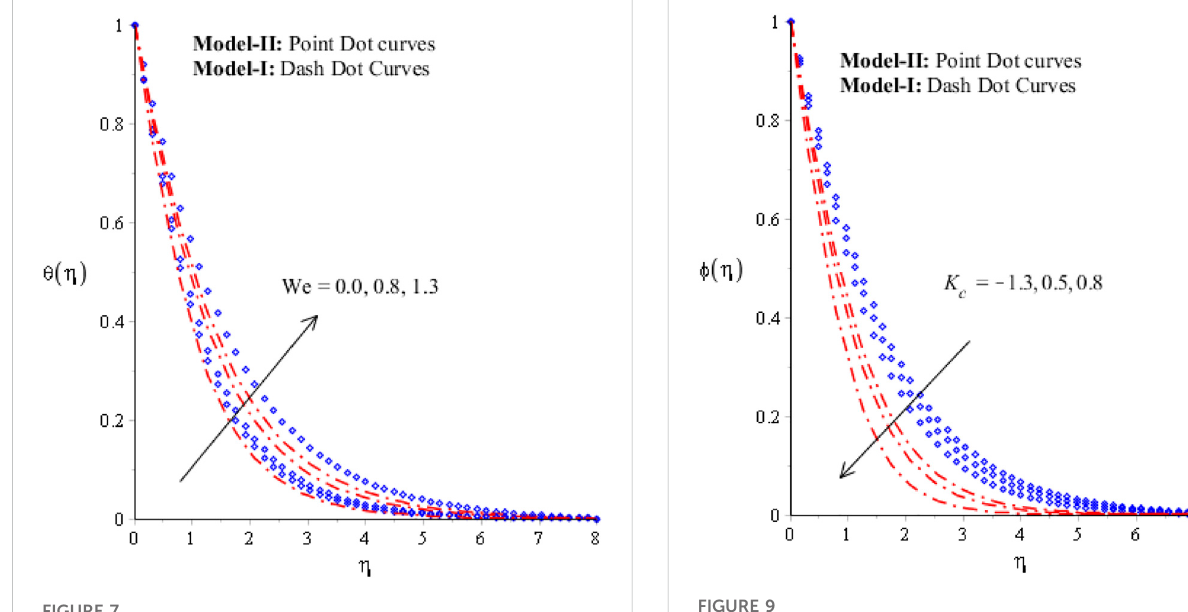
FIGURE 9 Effect of K c on concentration curves when α (cid:2) 2 . 0 , n (cid:2) 0 . 3 , Re